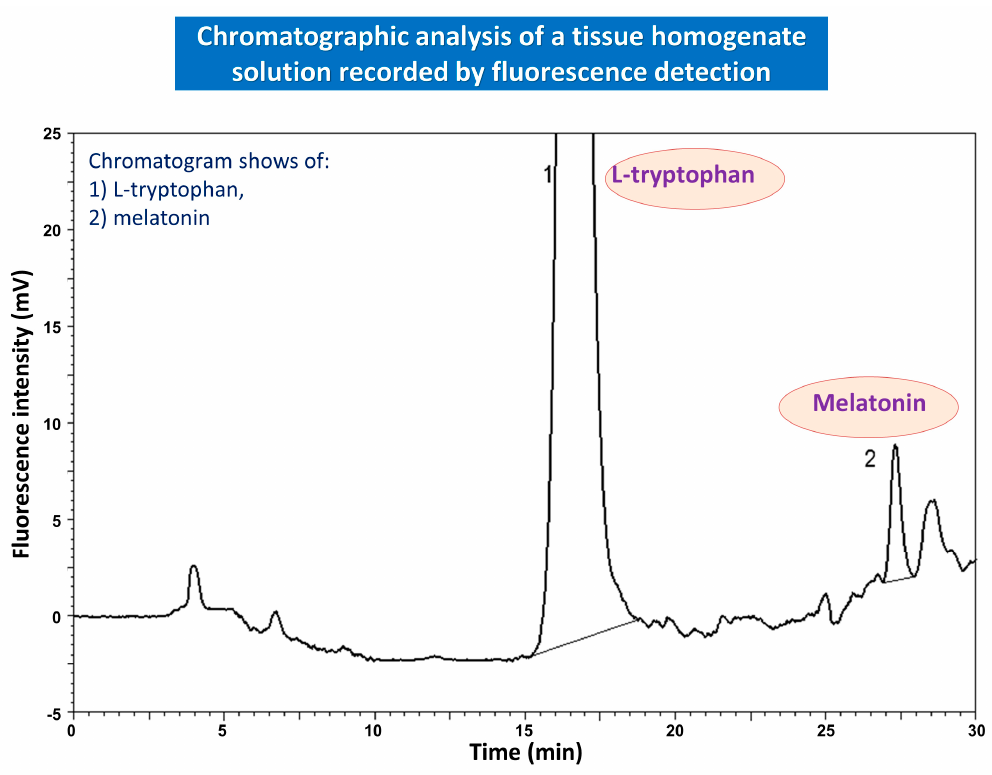
Figure 2. Chromatographic analysis of the tissue homogenate solution recorded by fluorescence detection presenting the conversion of L-tryptophan administered intragastrically in a dose of 100 mg/kg into melatonin in rat gastrointestinal tract. Chromatograms show particular peaks of melatonin derived from L-tryptophan in gastric mucosal tissue homogenates.